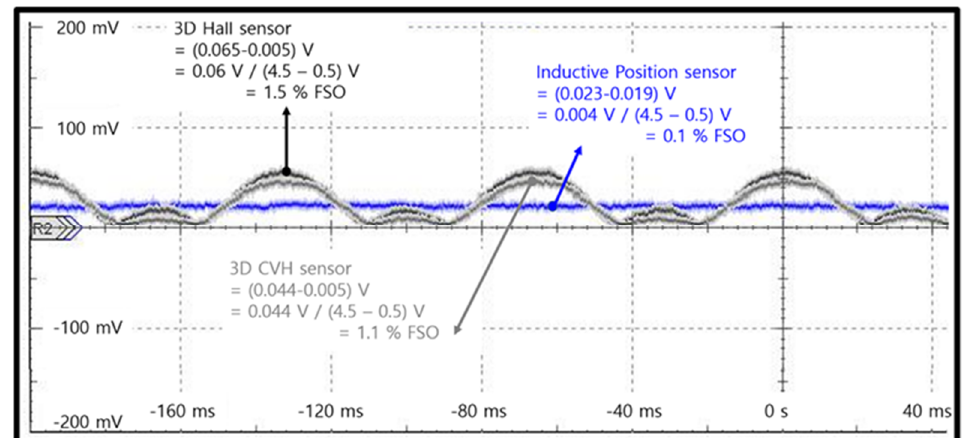
Figure 12. Schematic drawing of ISO11452-8 magnetic immunity test at 15 Hz and 1 kA/m. DUT: device under test.